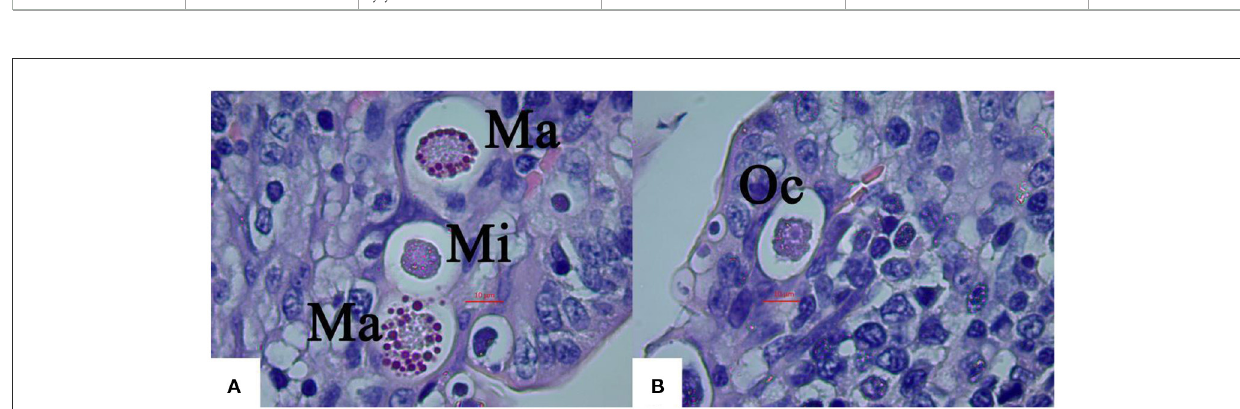
FIGURE4 Light micrographs of gametogony of E. kongi experimentally infected rabbits ( × 1,000). Scale bar = 20 µ m. (A) The microgamonts (Mi) and macrogamonts (Ma) of E. kongi in epithelial cells of ileal villi of rabbit at 132h p.i. (B) Developing oocysts (Oc) at 144h p.i.